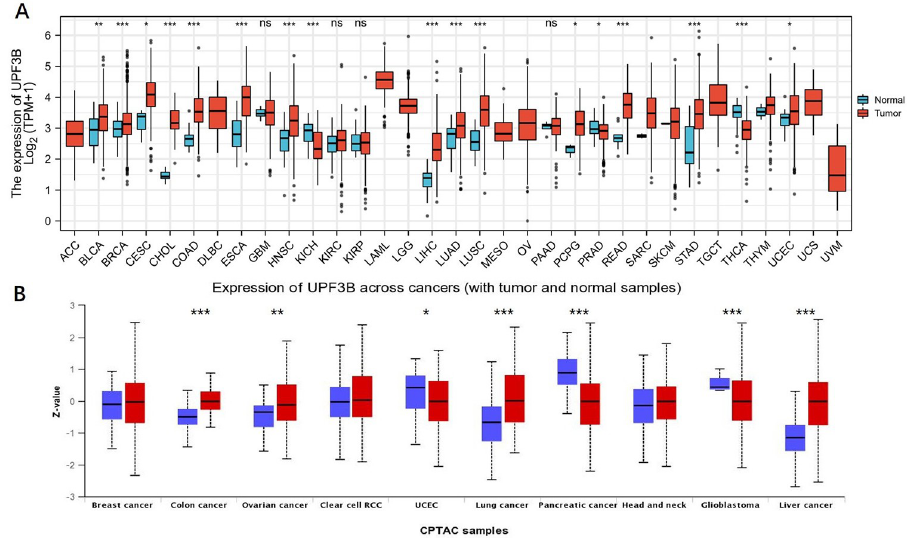
Fig 1. The transcription levels of UPF3B in human cancers. (A, B) The expression of UPF3B in different type of tumor tissues and normal tissues. Data was obtained via TCGA. (B)The protein levels of UPF3B in different types of cancers determined using UALCAN databases. � P < 0.05, �� P < 0.01, ��� P < 0.001.